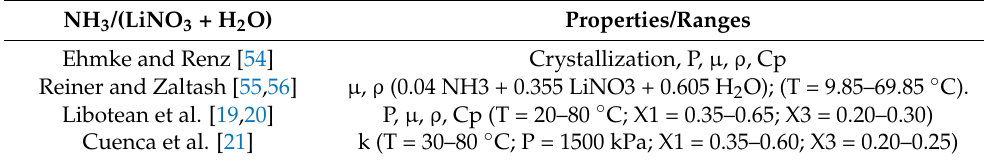
Table 3. State-of-the-art of thermodynamic properties of the NH 3 /(LiNO 3 + H 2 O) mixture. NH 3 /(LiNO 3 + H 2 O)